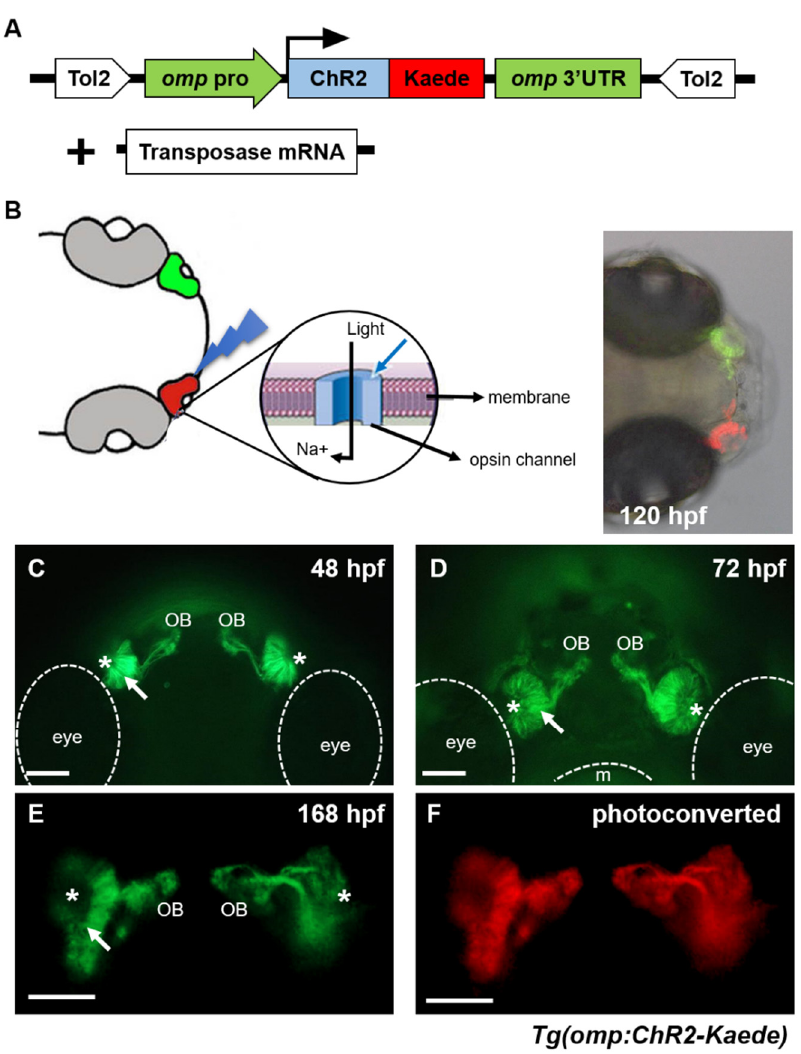
Figure 1. Generation of a transgenic zebrafish expressing ChR2-Kaede in olfactory sensory neurons. ( A ) Generation of transgenic fish using the expression construct of omp -driven ChR2-Kaede with transposase mRNA. ( B ) Schematic view of the transgenic zebrafish expressing channelrhodopsin-2 (ChR2) in olfactory sensory neurons. The green fluorescence of Kaede was photo-converted to red color, as an indicator for activation. ( C , D ) Ventral view of the head of the transgenic zebrafish embryos at 48 hpf and 72 hpf. ( E , F ) Dorsal view of the transgenic fish at 168 hpf. The Kaede protein of OSNs was photoconverted by UV light green to red fluorescence ( F ). Asterisks indicate the nasal pit, and arrows indicate the olfactory epithelium. m, mouth; OB, olfactory bulb. Scale bars, 50 µ